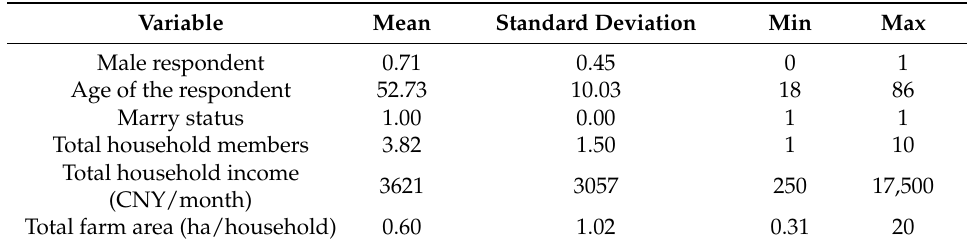
Table 1. Main socioeconomic characteristics of all the